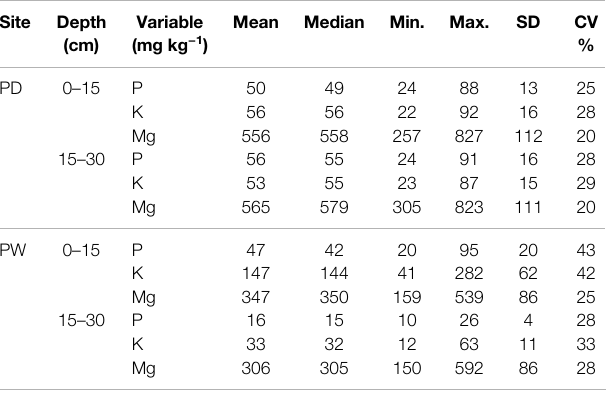
TABLE 3 | Plant available phosphorus, potassium, and magnesium in the surface and subsurface horizons of the drained and rewetted peatlands. Site Depth Variable Mean Median Min. (cm) (mg kg − 1 )